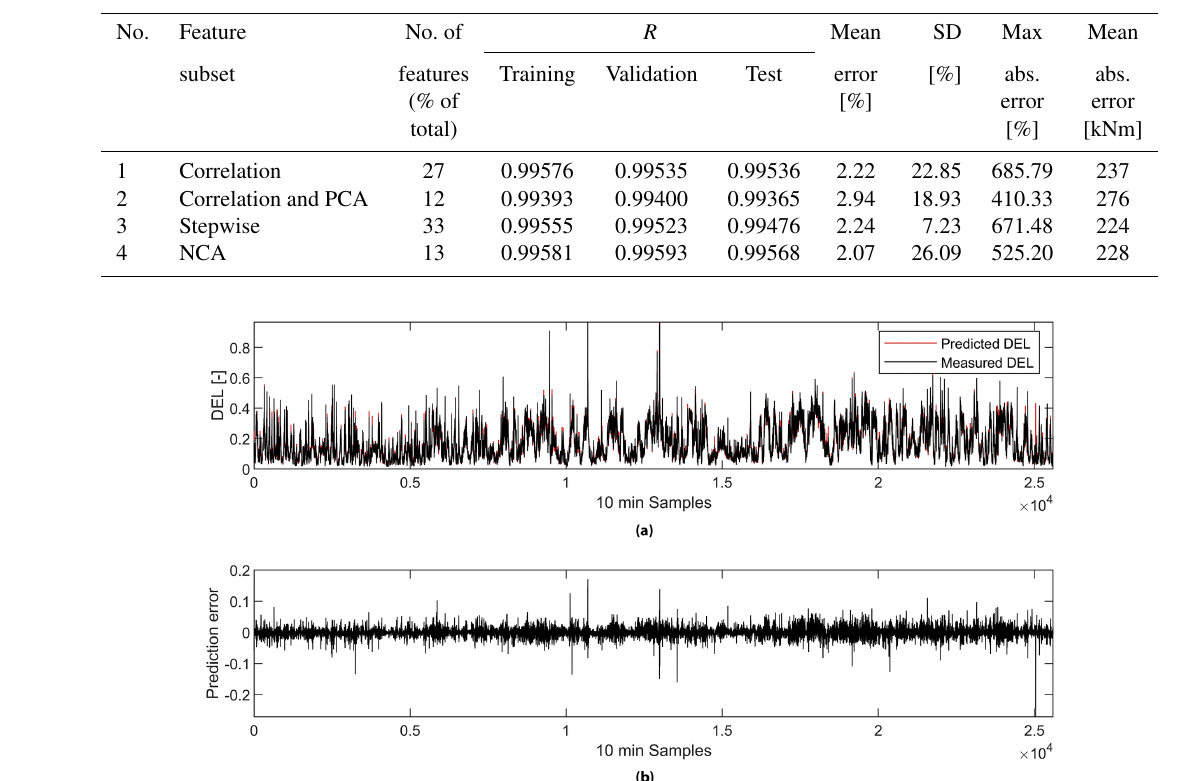
Figure 5. NN prediction. Plot (a) presents the normalized predicted and the measured DELs by the NN. Plot (b) is the prediction error.